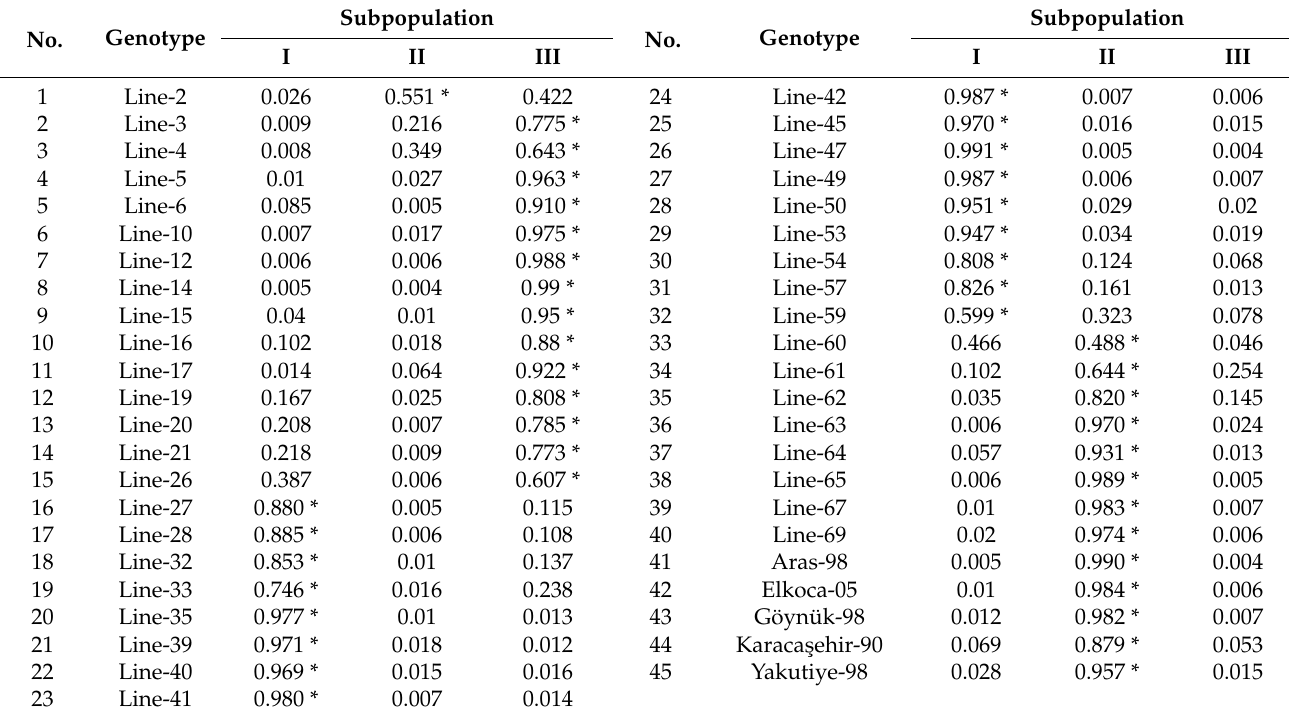
Table 9. Membership coefficient of bean genotypes in three subpopulations.